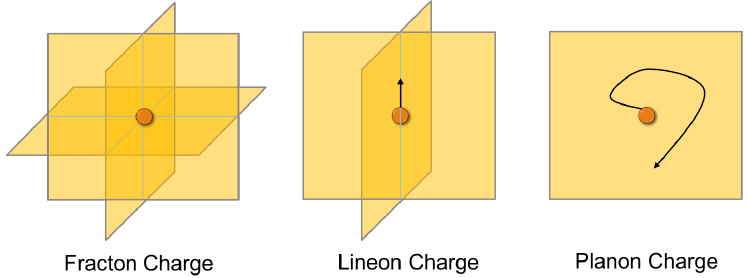
Figure 6: Symmetry charges transforming under planar symmetries in three, two, one directions are fractons (cannot move), lineons (can move only along a line), and planons (can move only in a plane)